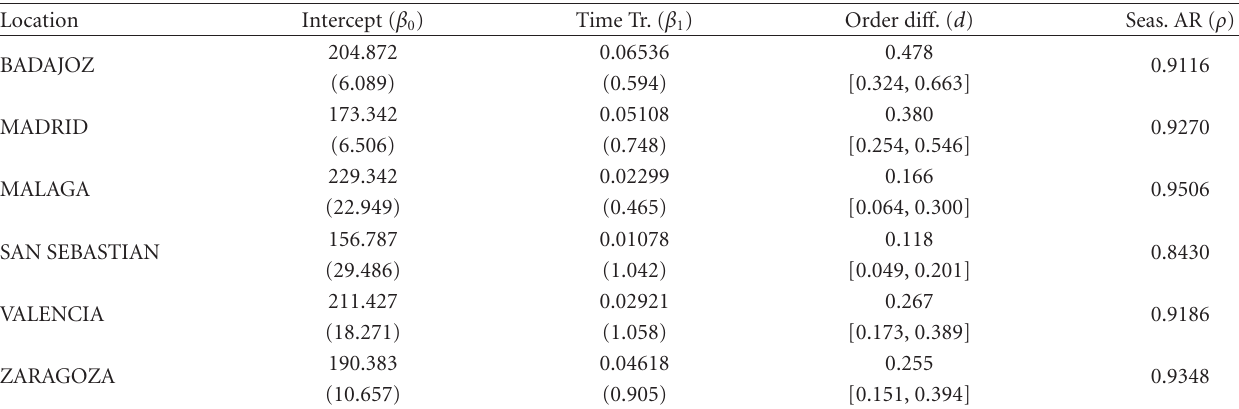
Table 1: Estimates of the time trend coe ffi cients, the fractional di ff erencing parameters, and the seasonal AR(1) coe ffi cients. Series: T max . ( t -values in parenthesis. In brackets the 95% confidence bands for the orders of